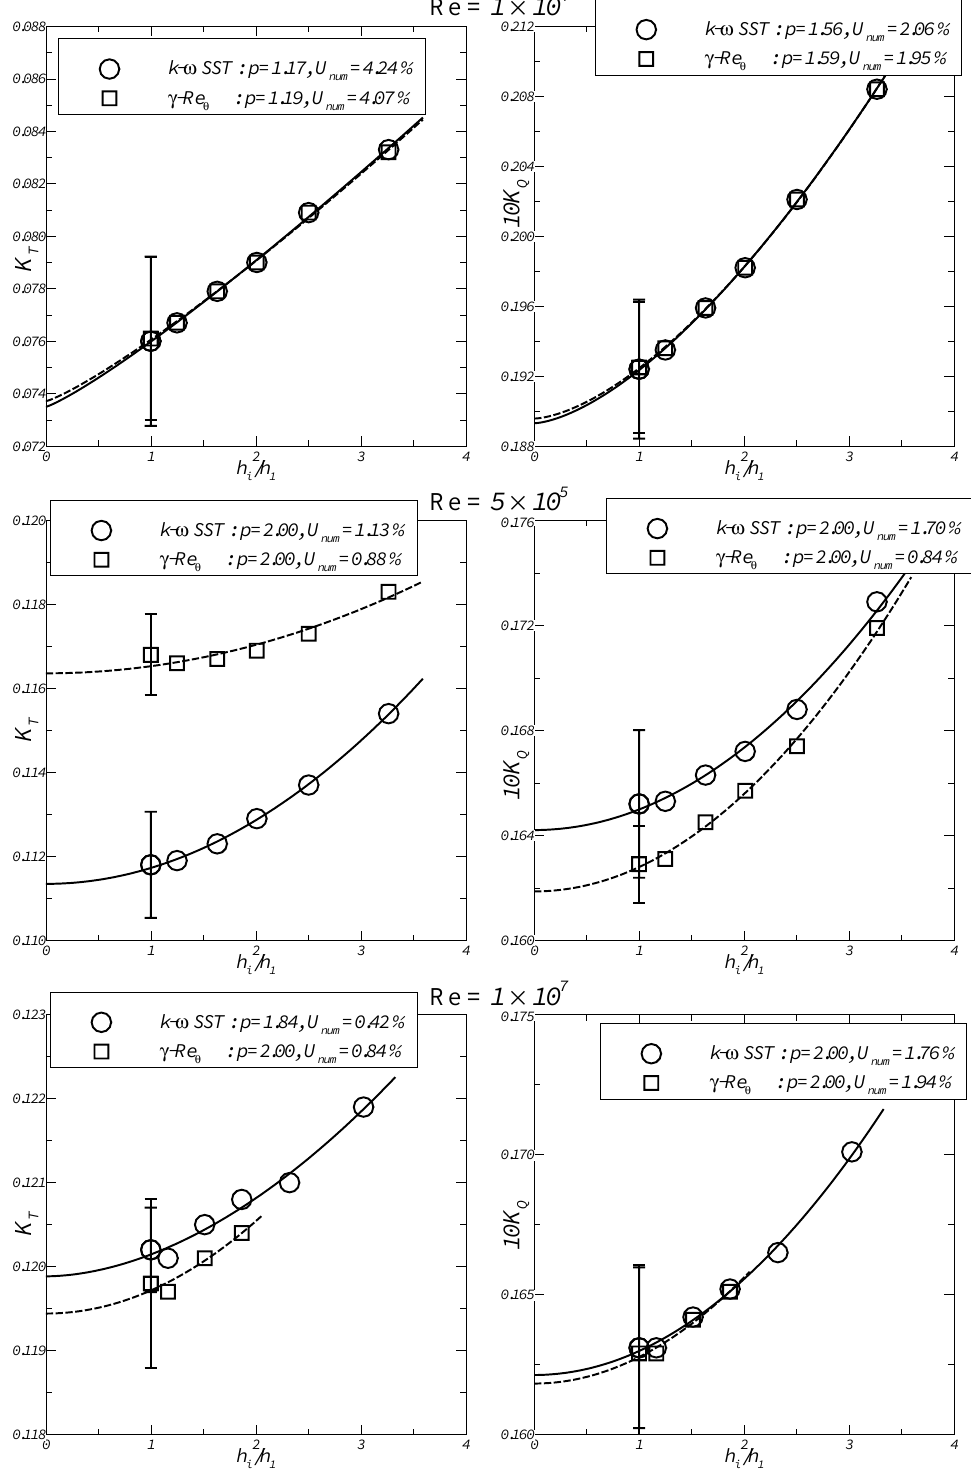
Figure 5. Convergence of K T ( left ) and 10 K Q ( right ) with the grid refinement ratio h i / h 1 at J = 0.568: Re = 1 × 10 4 ( top ), 5 × 10 5 ( middle ) and 1 × 10 7 ( bottom